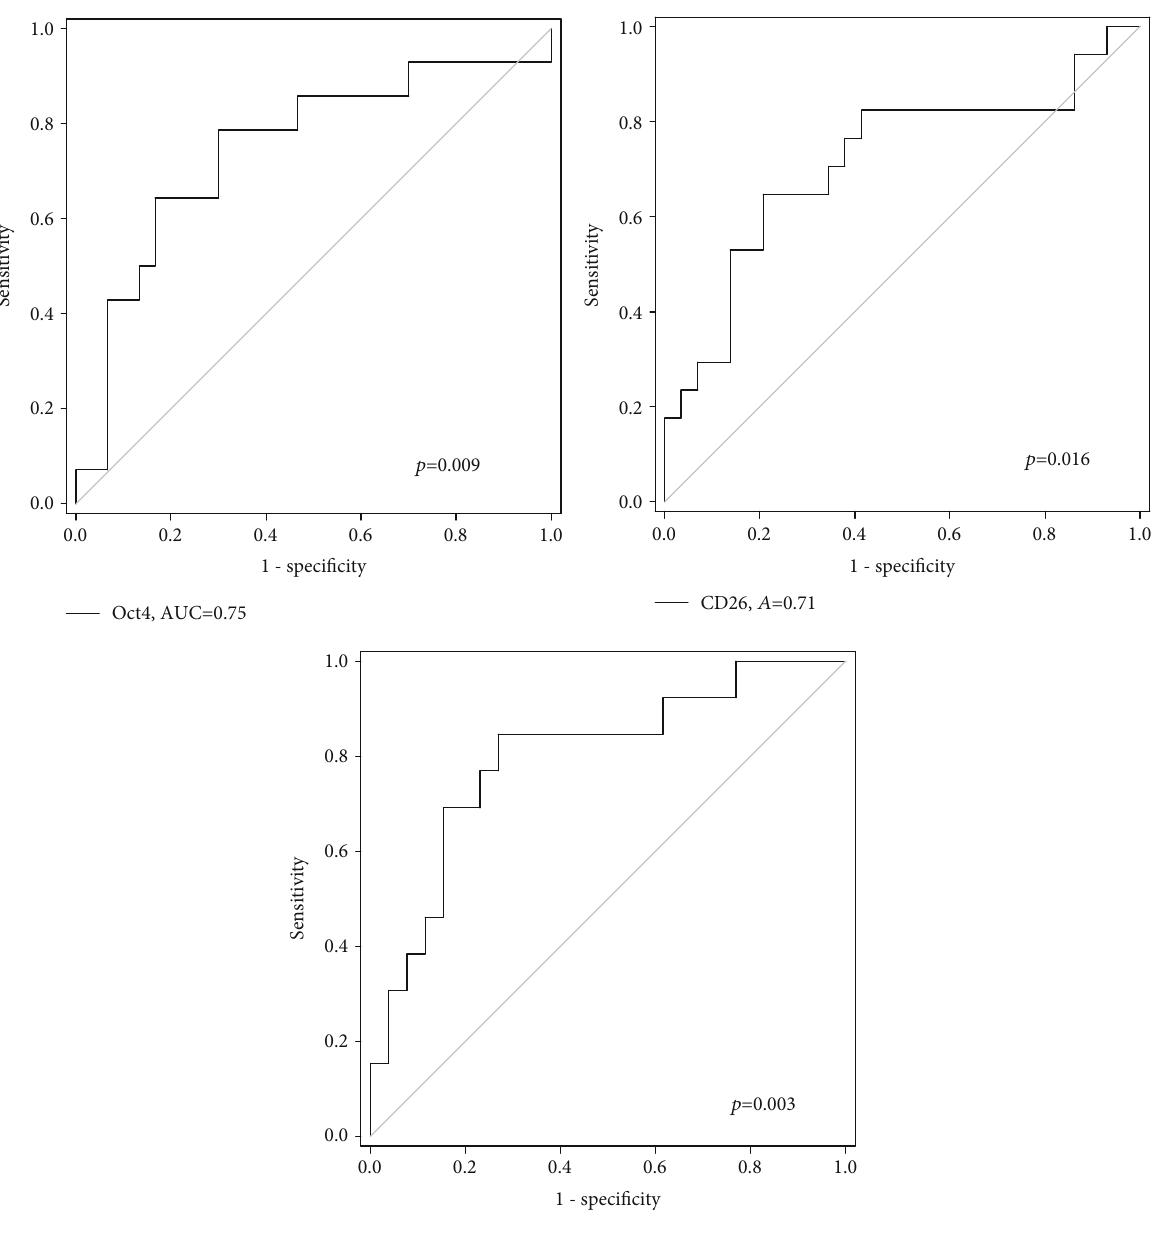
Figure 4: ROC analyses of Oct4 and CD26 and their combination for identi fi cation of CRC patients from normal and polyp